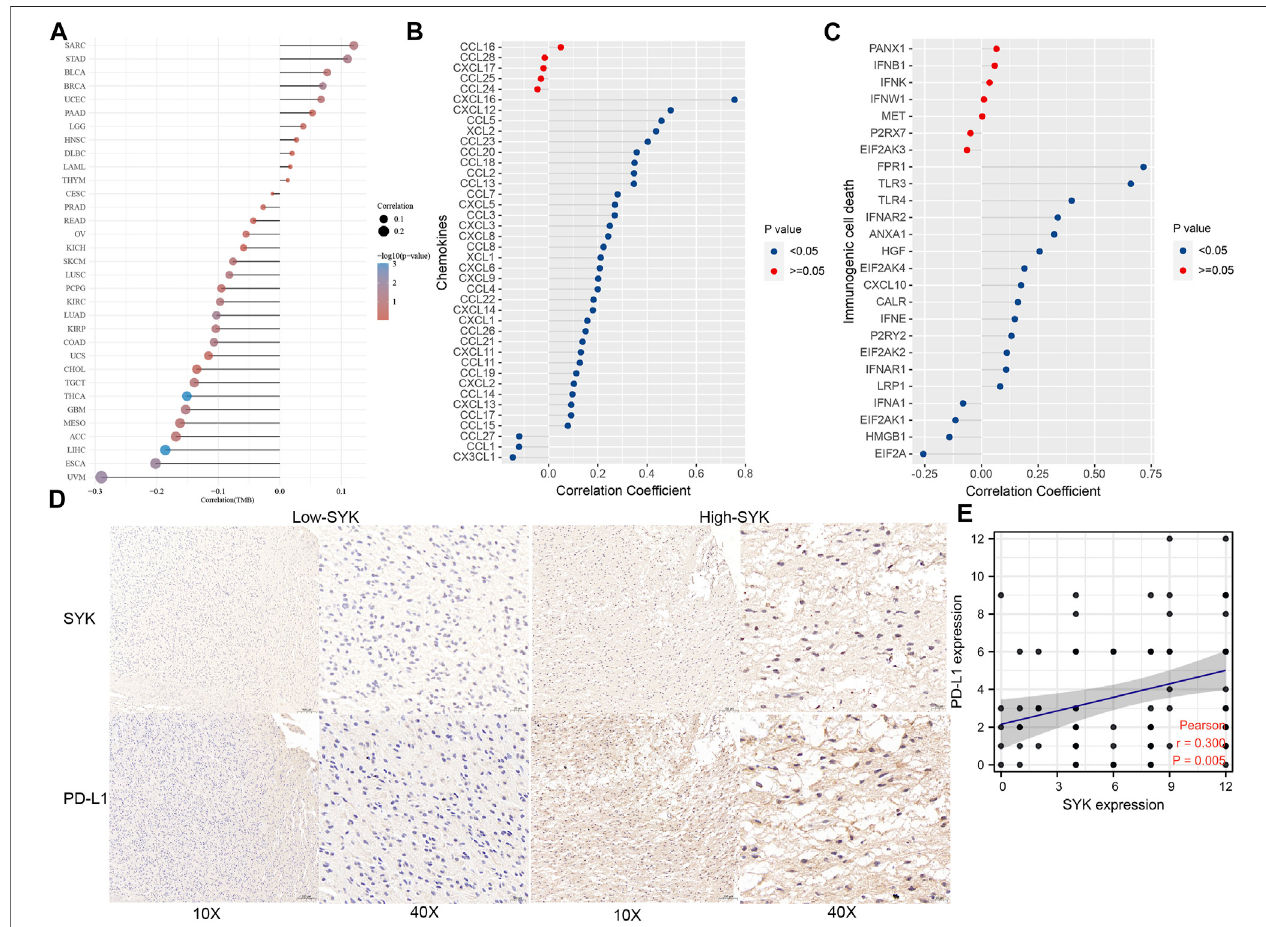
FIGURE 8 | Correlation between SYK expression and TMB, chemokines and immunogenic cell death modulator-related genes, and PD-L1. (A) The correlation between SYK expression and TMB in pan-cancer. (B,C) The correlation between SYK expression and the expression of chemokines (B) and immunogenic cell death modulator (C) -related genes in diffuse glioma. (D,E) The correlation between SYK expression and PD-L1 expression by IHC staining.